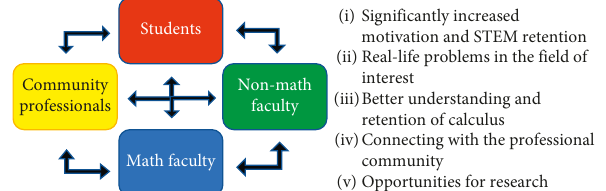
Figure 4: Applied mathematics projects connect students with academic and industrial STEM professionals [4,